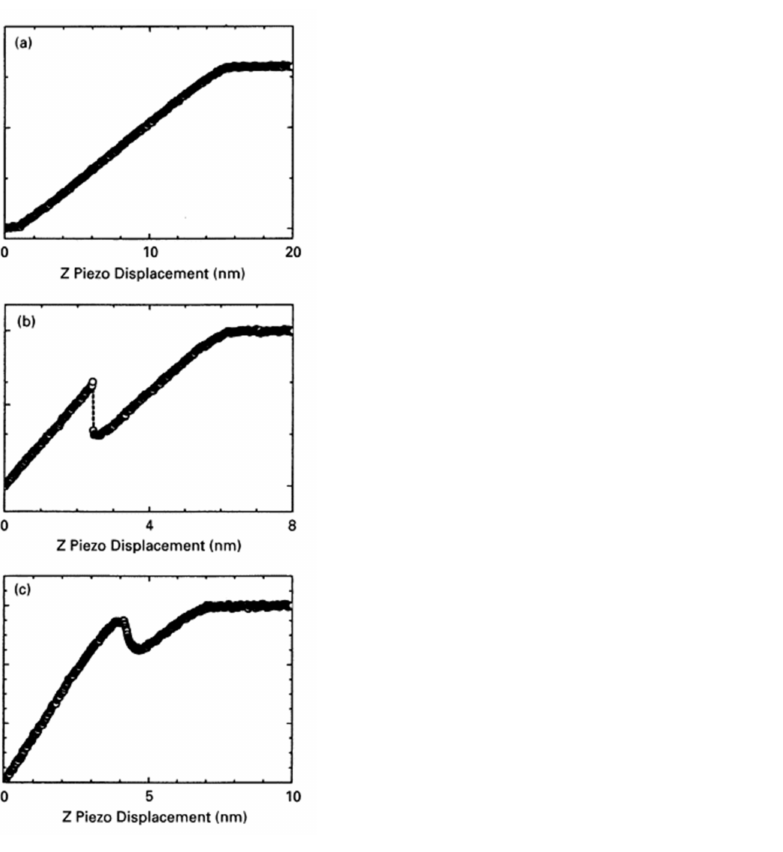
Figure 5. Measured amplitudes vs. z-displacements between tip and sample surface for ( a ) mica (free amplitude 16 nm); ( b ) InAs/GaAs (free amplitude 15 nm); and ( c ) InAs/GaAs (free amplitude 40 nm). Reprinted from [22], Copyright (2000), with permission from